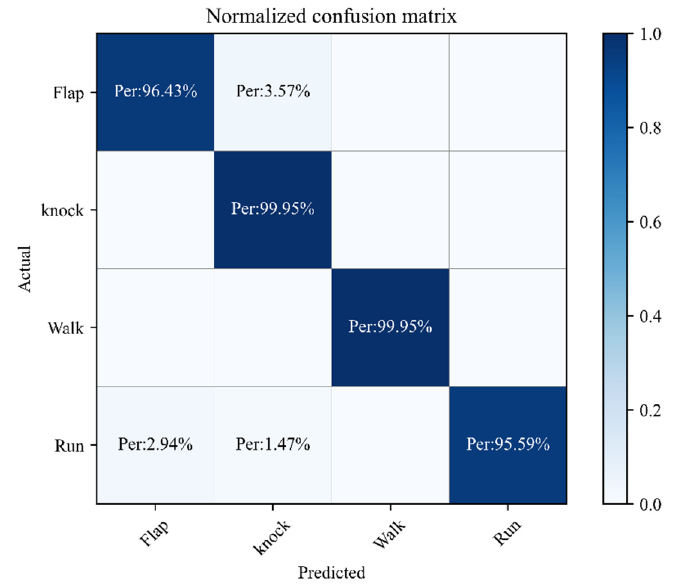
Figure 10. Confusion matrix. Table 2. Performance evaluation form.